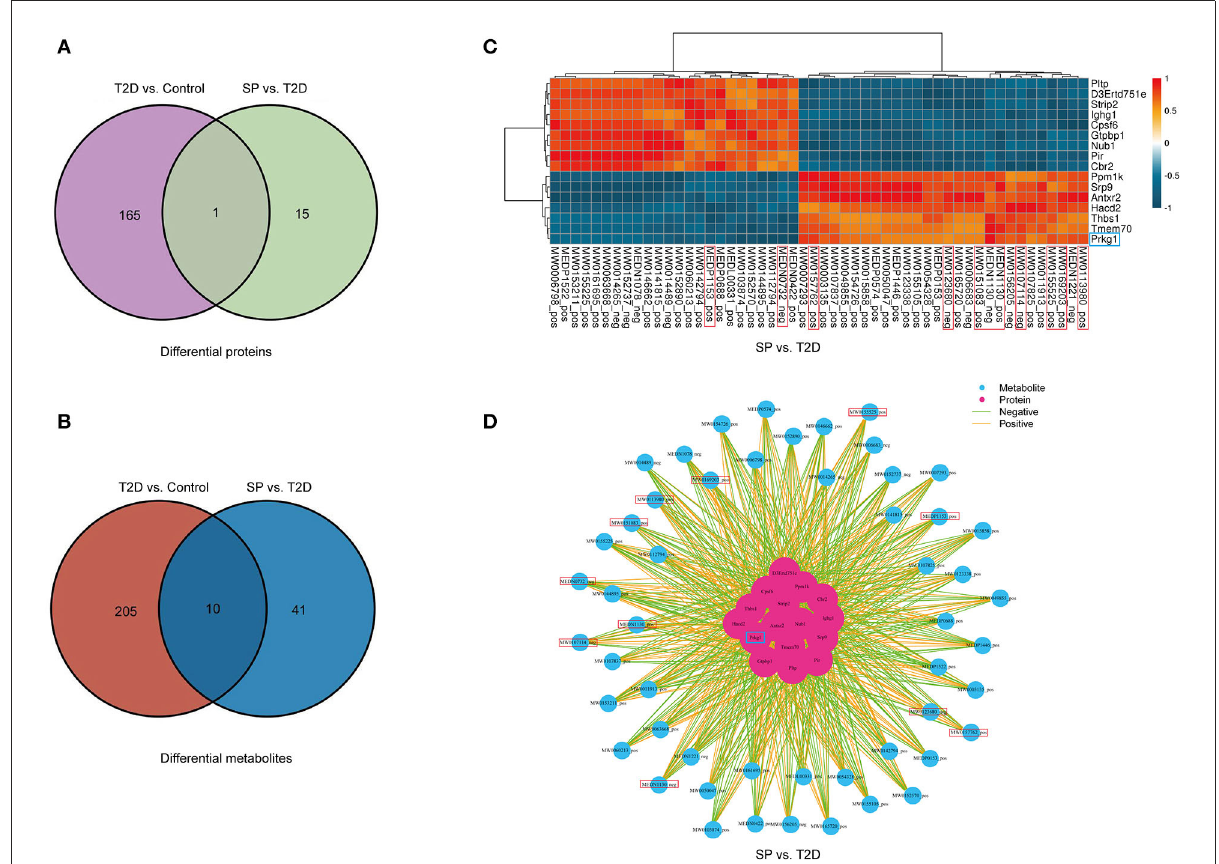
FIGURE6 Correlation analysis of proteomics and metabolomics reveals the role of SP in DCM. (A) Venn diagrams displaying the one overlapped protein that is differentially expressed in both T2D/Control and T2D + SP/T2D groups. (B) Venn diagrams displaying the 10 overlapped metabolites that are differentially expressed in both T2D/Control and and T2D + SP/T2D groups. (C) The heatmap displaying the regulatory relationship of DEPs and the differentiated metabolites in db/db mice treated with SP. (D) Protein–metabolite correlation network analysis in db/db mice treated with